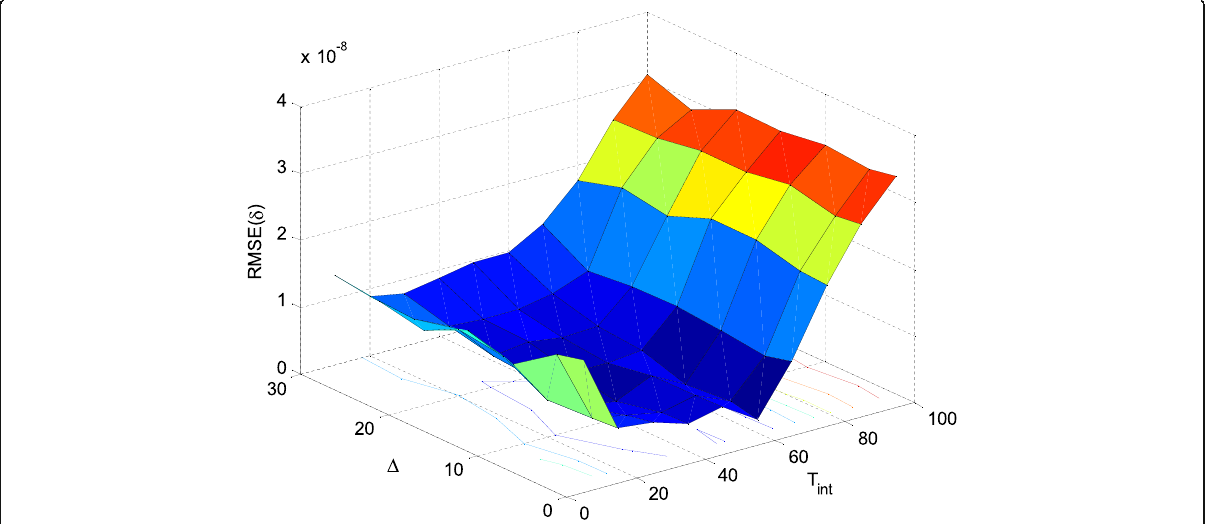
Fig. 9 RMSE of TD energy detection estimator vs. integration window length Tint and integrating step Δ , for NLOS scenario